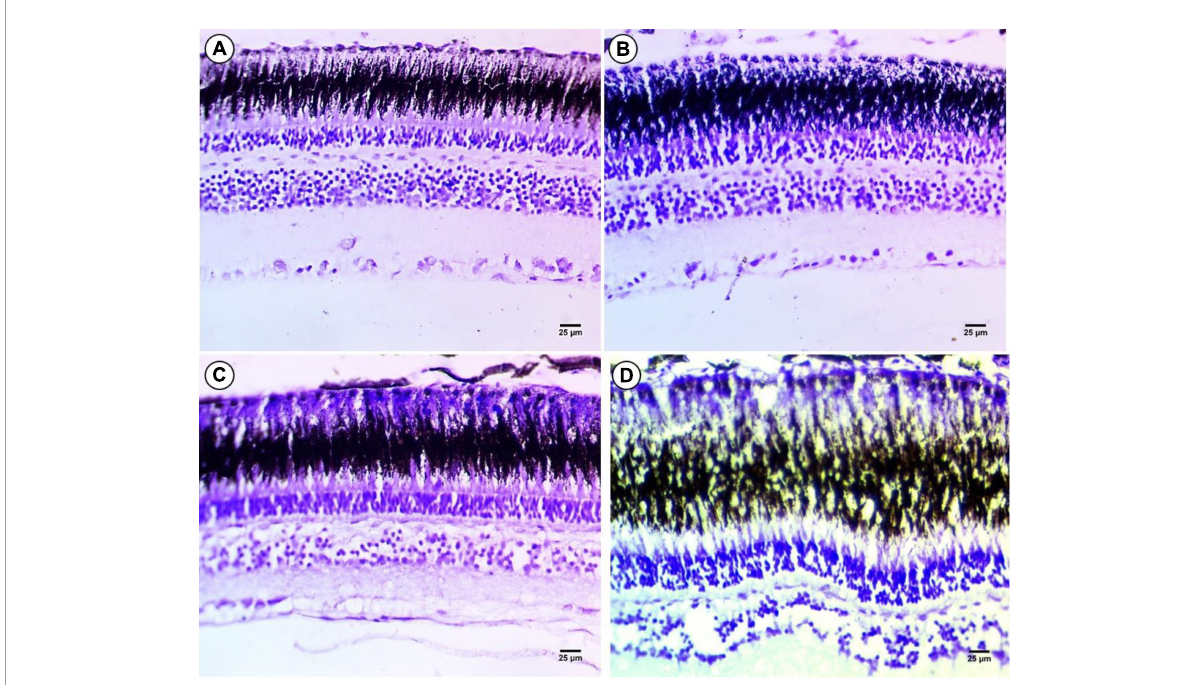
FIGURE4 Sections of control and treated fish retina. (A) Sections of control fish retina showing positive staining in all layers of the retina of fish. (B) Exposure to 100 mg/L of macroplastic for 15 days showing slight positive staining in the four layers of the retina. (C) Exposure to 100 mg/L of microplastic for 15 days showing negative staining in the four layers of the retina. (D) Exposure to 100 mg/L of nanoplastic for 15 days showed negative staining in all layers of the retina (cresyl violet stain ×